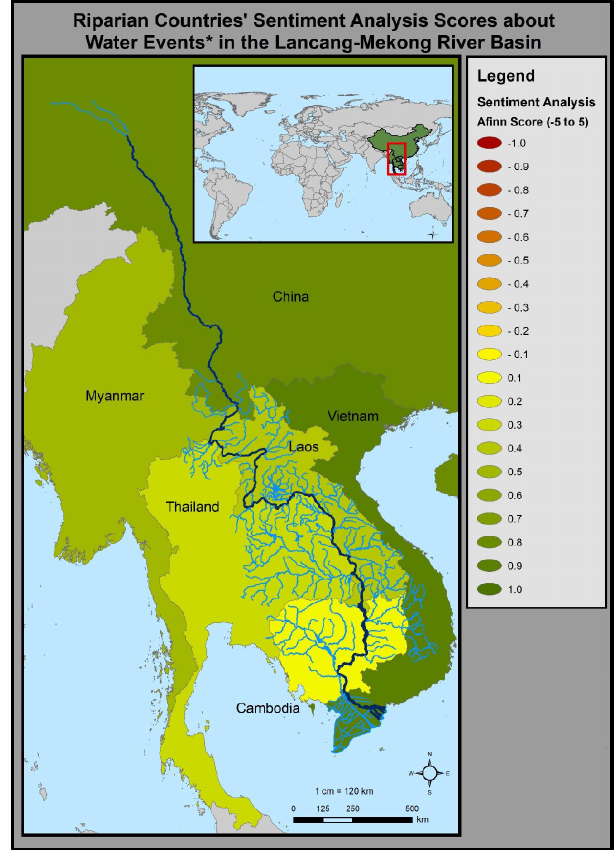
Figure 7. Average conflict and cooperation sentiment score of each riparian country between 1991 and